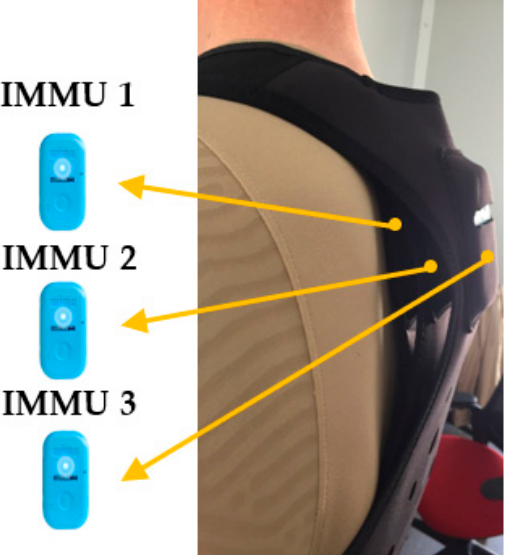
Figure 2. Location of the WIMU devices with the use of the vests.